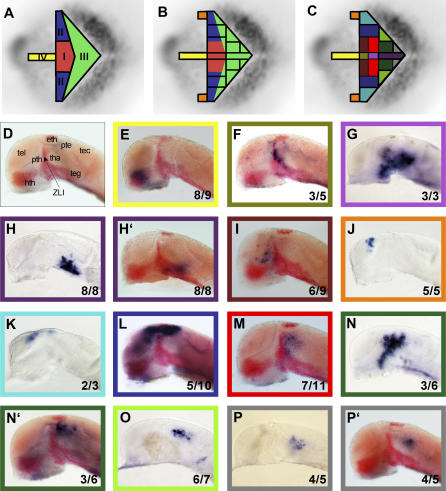
Fate of Caudal Forebrain Precursors(A) Schematic showing the four different diencephalic expression domains identified in Figure 1.(B) Arbitrary subdivision grid of the caudal forebrain shown on top of the expression domains plus an additional telencephalic subdomain (orange).(C) Colour code used for the final 12 domains investigated.Embryos in (D, E, F, H′, I, L, M, N′, and P′) show the expression of shh and otx5 in red.(D) Different areas of the rostral brain are labelled on an embryo showing expression of shh (in the ZLI) and otx5 (in the pineal gland) in red.(E) Cells of the bright yellow midline area are found in the hypothalamus.(F) Cells inside the lime midline domain populate the ventral ZLI.(G) The light violet area spans the posterior hypothalamus, the basal ZLI, posterior tuberculum, and some of the anterior tegmentum.(H and H′) Cells of the caudal-most midline domain of the forebrain are detected in the anterior tegmentum.(I) Cells labelled in the dark red domain of the neural plate contribute to the prethalamus.(J) Precursors of the orange area will populate the posterior dorsal-most telencephalon.(K) The light blue includes precursors of the dorsal telencephalon and the epithalamus.(L) The dark blue area marks cells of the dorsal telencephalon, epithalamus, and dorsal pretectum.(M) In the light red area, we found precursors of the thalamus.(N–P) (N and N′) Cells of the dark green domain can be found in the dorsal thalamus and, in some cases, in a stream of cells running down to the posterior hypothalamus (N′). Precursors of the light green area (O) populate parts of the pretectum and the tectum whereas cells of the grey area (P and P′) were detected in cells close to the midbrain.Because of the nature of the experiment (negative landmarks and fast developing embryos), we were not always reproducibly labelling the same cells in each experiment. Therefore, one can find, for each experiment, the number of embryos we labelled per experiment and how many of these result in the shown cell labelling. (For example 8/9 means eight out of nine embryos show the same labelling in the area depicted in the picture).eth, epithalamus + pineal gland; hth, hypothalamus; pte, pretectum; pth, prethalamus; tec, tectum; teg, tegmentum; tel, telencephalon; tha, thalamus.